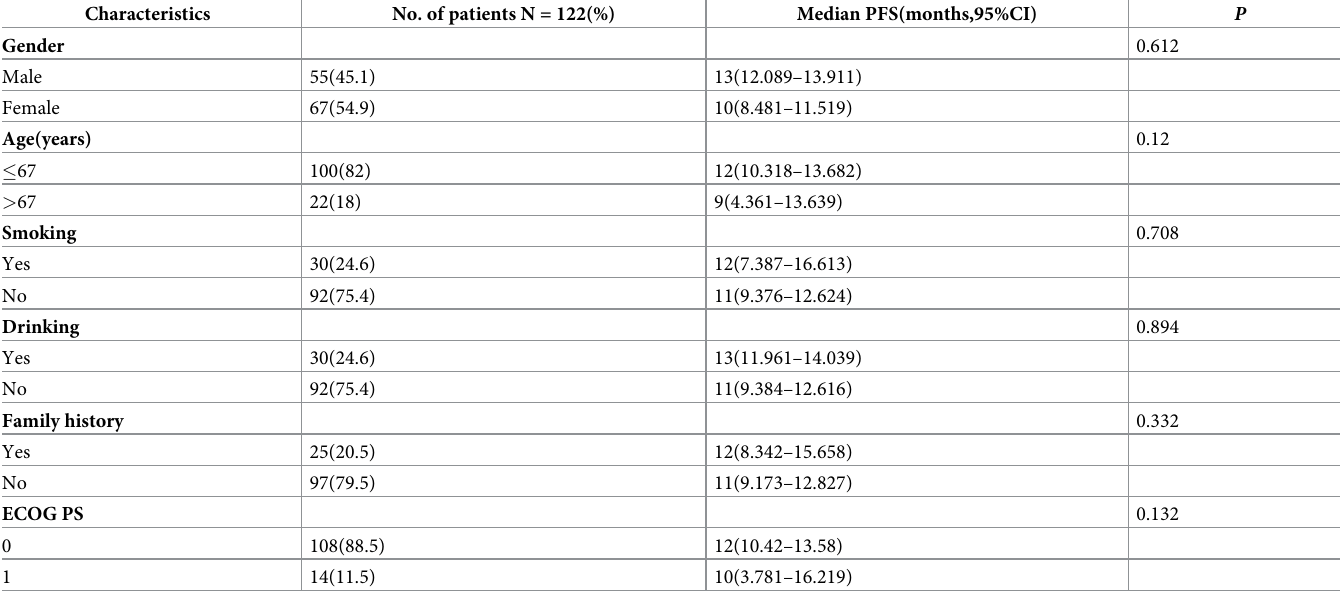
Table 1. Univariate analysis of 122 patients with EGFR exon19 mutation.